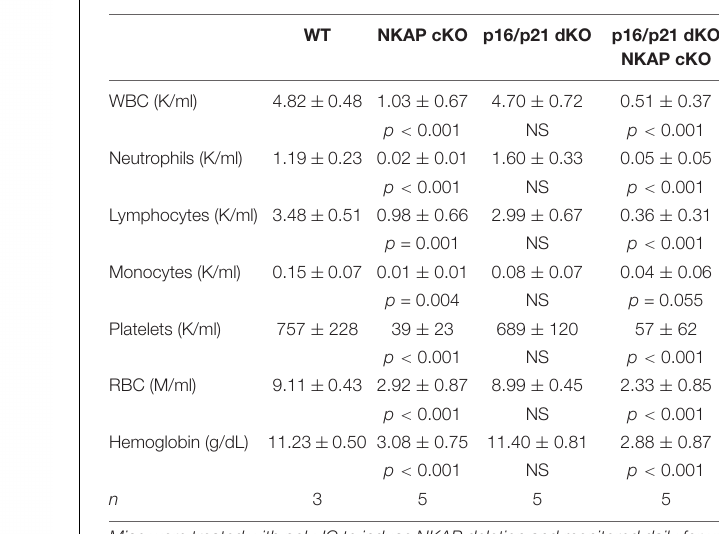
TABLE 1 | The effect of NKAP deficiency on peripheral blood